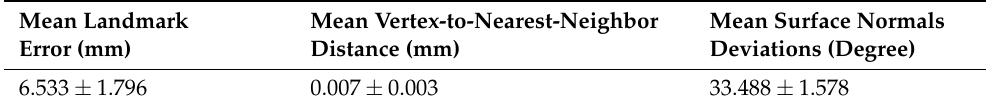
Table 2. Mean error and standard deviation for the N-ICP-A method.